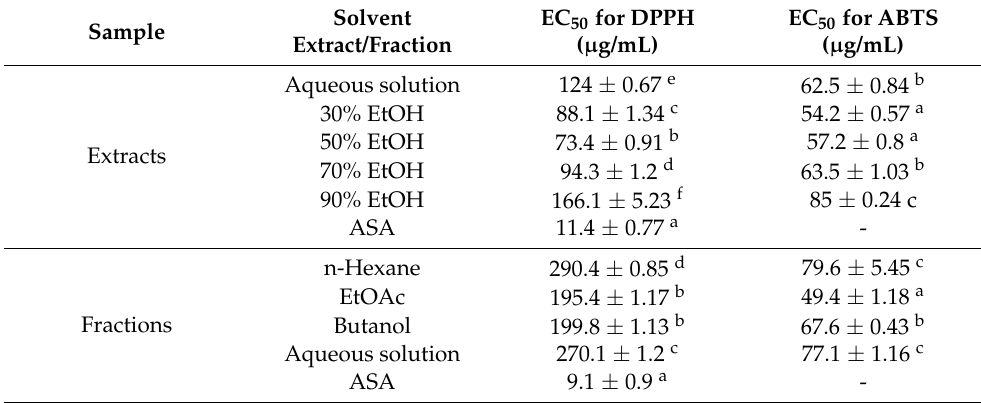
Table 2. DPPH and ABTS radical scavenging activity of P. thunbergiana L. EtOH extracts and fractions (ASA: ascorbic acid). Results are expressed as mean values ± standard deviation ( n = 3). Means with different superscript letters ( a–f ) indicate statistically significant differences ( p <